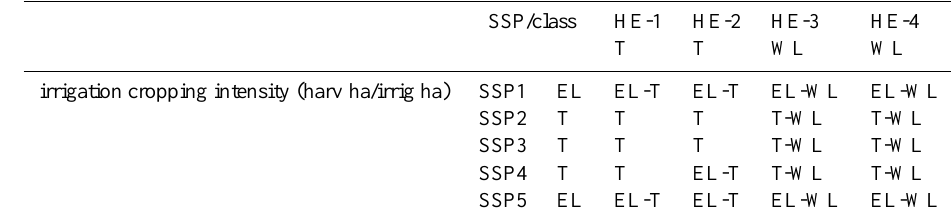
Table A6. Water dimension – irrigation cropping intensity assumptions.